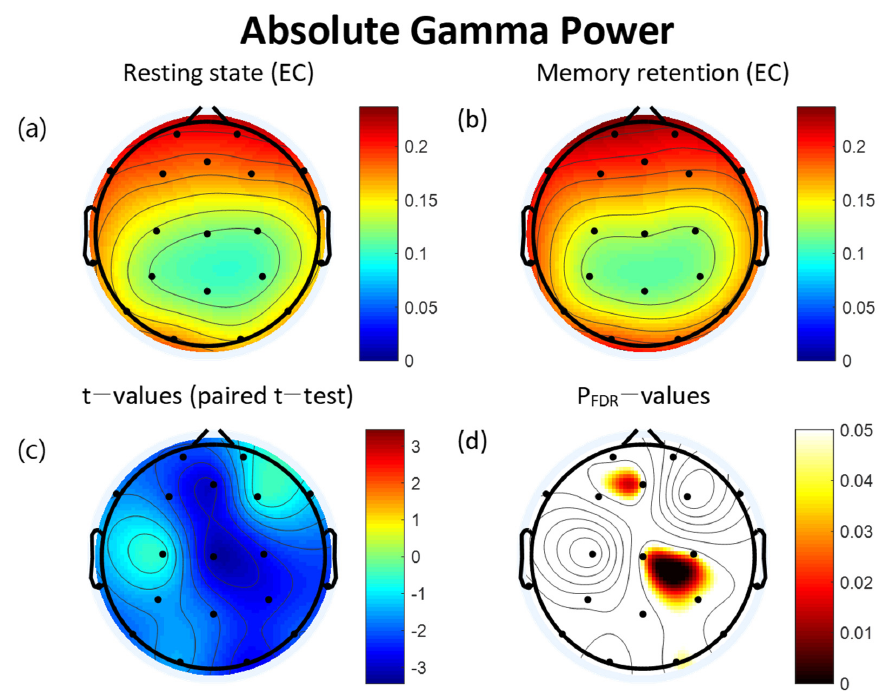
Figure 3. Topographies of absolute gamma power during eyes-closed resting state and the retention interval of the visual working memory (VWM) task, t -map, and p FDR -map. ( a ) Absolute spectral power of the gamma band during the resting state. ( b ) Absolute gamma power during the retention interval of the VWM task. ( c ) Topographical distribution of t -values (paired t -test). ( d ) Topographical distribution of the corresponding False Discovery Rate corrected p -value (paired t -test). EC: eyes closed. FDR: False Discovery Rate. Table 4. Comparisons of the MI of TGC during the resting state and the retention interval of the VWM task in healthy